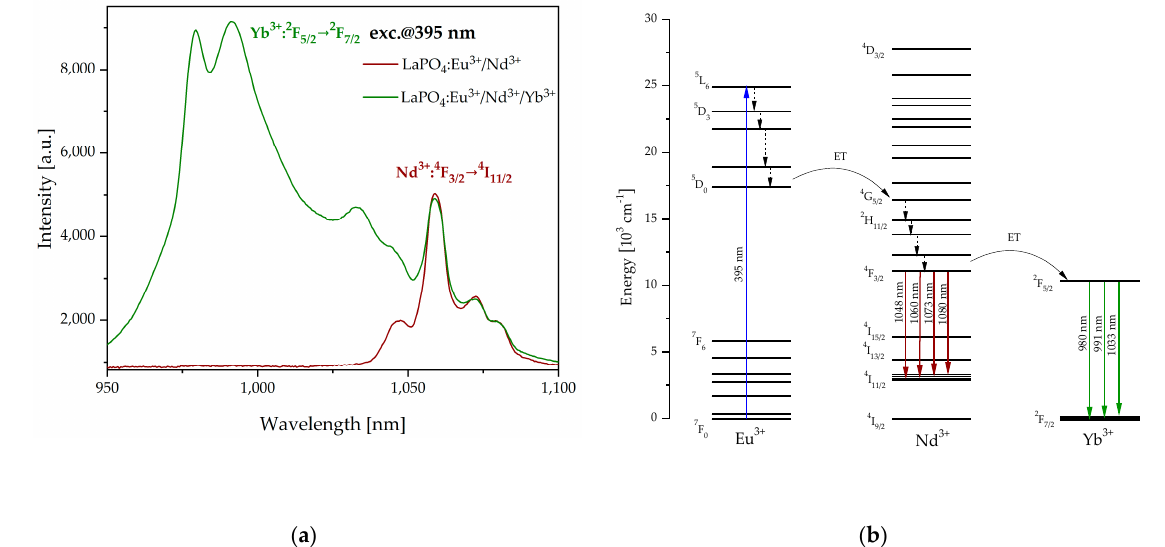
Figure 5. Luminescence spectra of LaPO 4 :Eu 3+ /Nd 3+ and LaPO 4 :Eu 3+ /Nd 3+ /Yb 3+ ( a ) and simplified energy level diagram of Eu 3+ , Nd 3+ , and Yb 3+ ( b ) illustrates the possible mechanism of energy transfer and radiative transitions in second biological window.